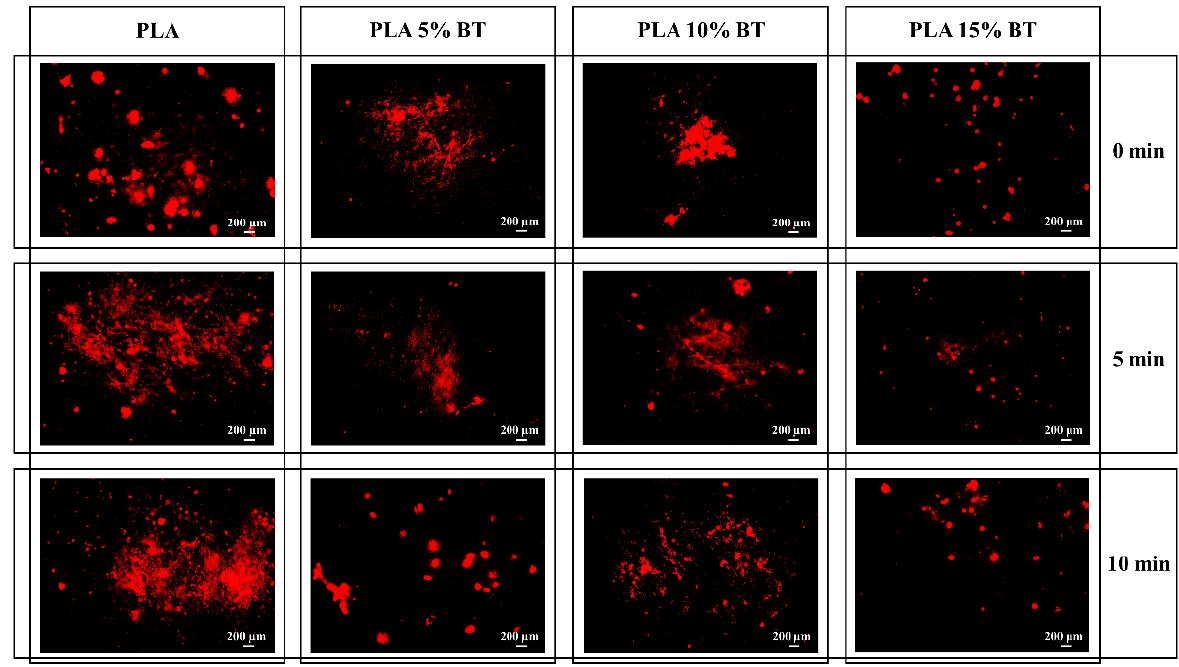
Figure 11. Fluorescence micrographs after CTC staining of S. epidermidis exposed for 12 h to the four substrates. Images were obtained at a 4 × magnification.